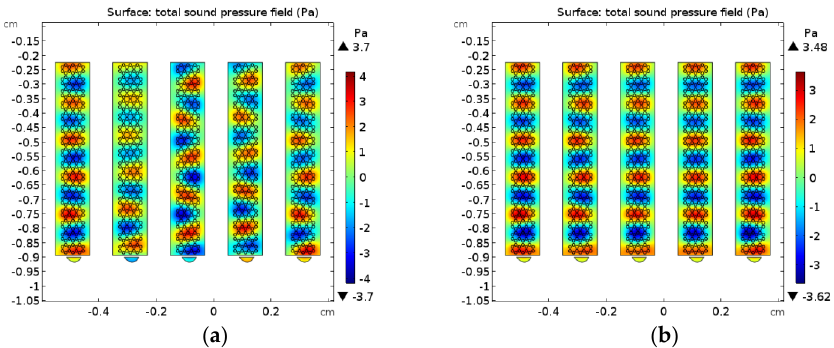
Figure 7. ( a ) Sound field distribution before phase modulation; ( b ) sound field distribution after phase modulation.